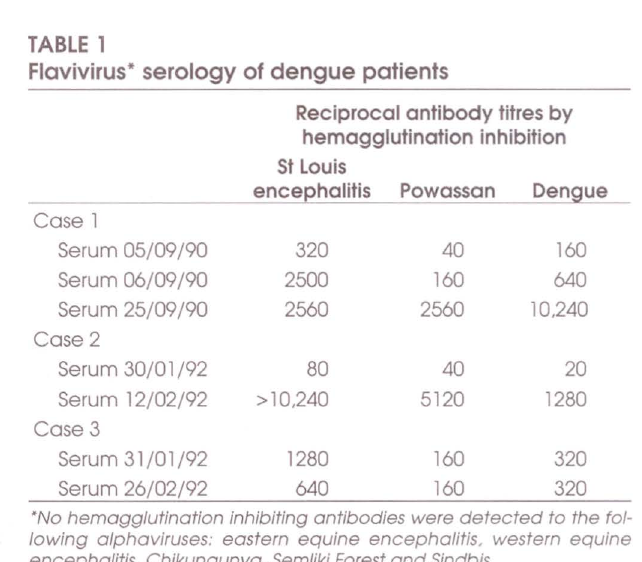
Flavivirus* serology of dengue